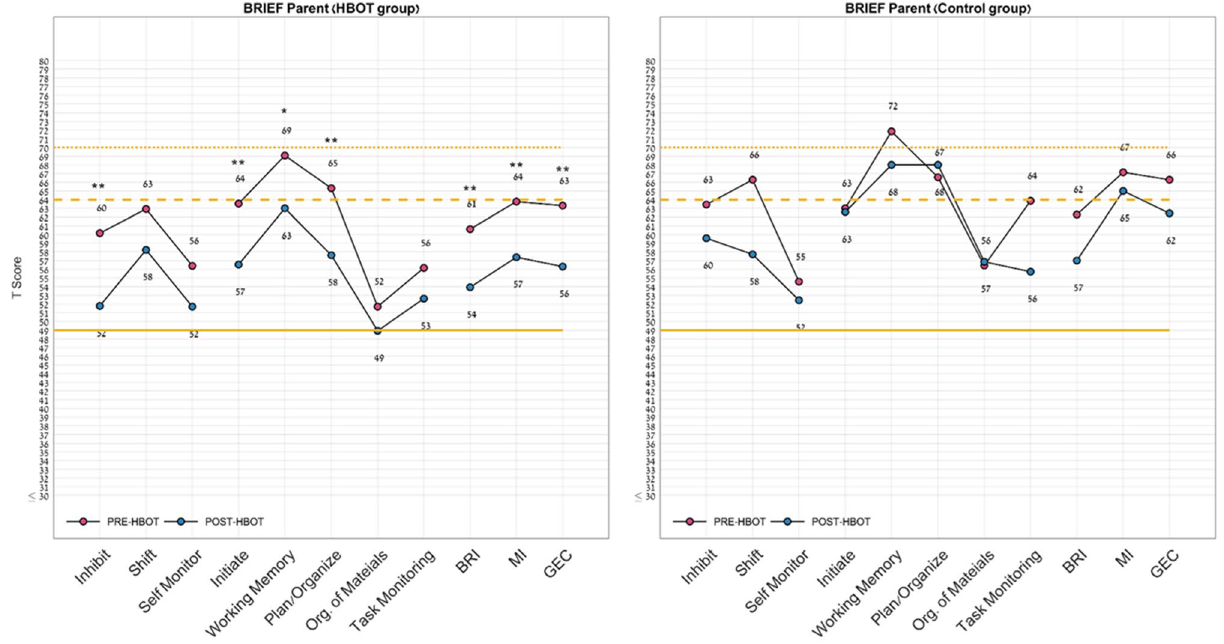
Figure 4. Behavior rating inventory of executive function questionnaire domains change. Following HBOT, the BRIEF questionnaire showed significant improvements in the inhibit, initiate, working memory, planning, behavioral regulation index, metacognition and global executive composite scores. Normal range, [49–64]; BRIEF behavior rating inventory of executive function. *P < 0.05; **P < 0.01; See Table 4 for full statistical information.